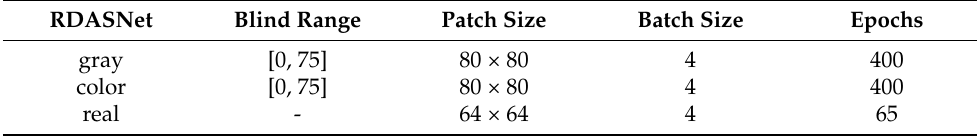
Table 1. Main parameters of